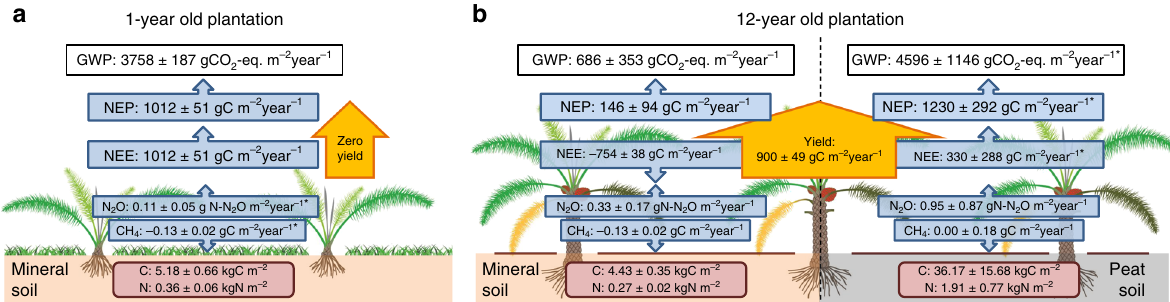
Fig. 1 Measured greenhouse gases at the oil palm plantations. Ecosystem greenhouse gases measured at the young (1-year-old; a ) and mature (12-year- old; b ) oil palm plantations on mineral soils (- b , left) and peat soils (- b , right). Greenhouse gas fl uxes (blue boxes) of carbon dioxide, i.e., net ecosystem exchange (NEE) measured at the ecosystem level using the eddy covariance technique, and of soil methane (CH 4 ) and nitrous oxide (N 2 O) fl uxes measured using vented static chambers. Net ecosystem productivity (NEP) is estimated as the sum of yield (which is zero in case of the young plantation) and NEE. Further presented are soil organic carbon and nitrogen stocks in the top 30 cm of the soil (red boxes) and the ecosystem net global warming potential (GWP, black boxes). Negative and positive fl uxes indicate uptake and emission, respectively. See Supplementary Tables 1 and 2 for additional details on all presented fl uxes. * indicates that fl uxes were not directly measured in our study sites, but estimated from other